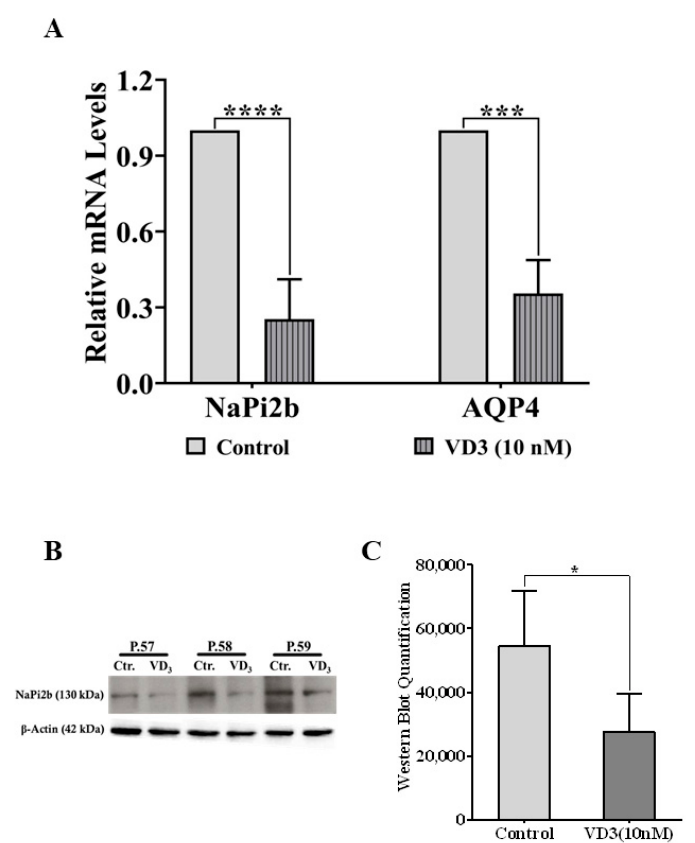
Figure 8. Expression of the cell membrane transport proteins NaPi2b and AQP4 in NCI-H441 cells. ( A ) mRNA levels of NaPi2b and AQP4 in NCI-H441 cells evaluated through real-time PCR